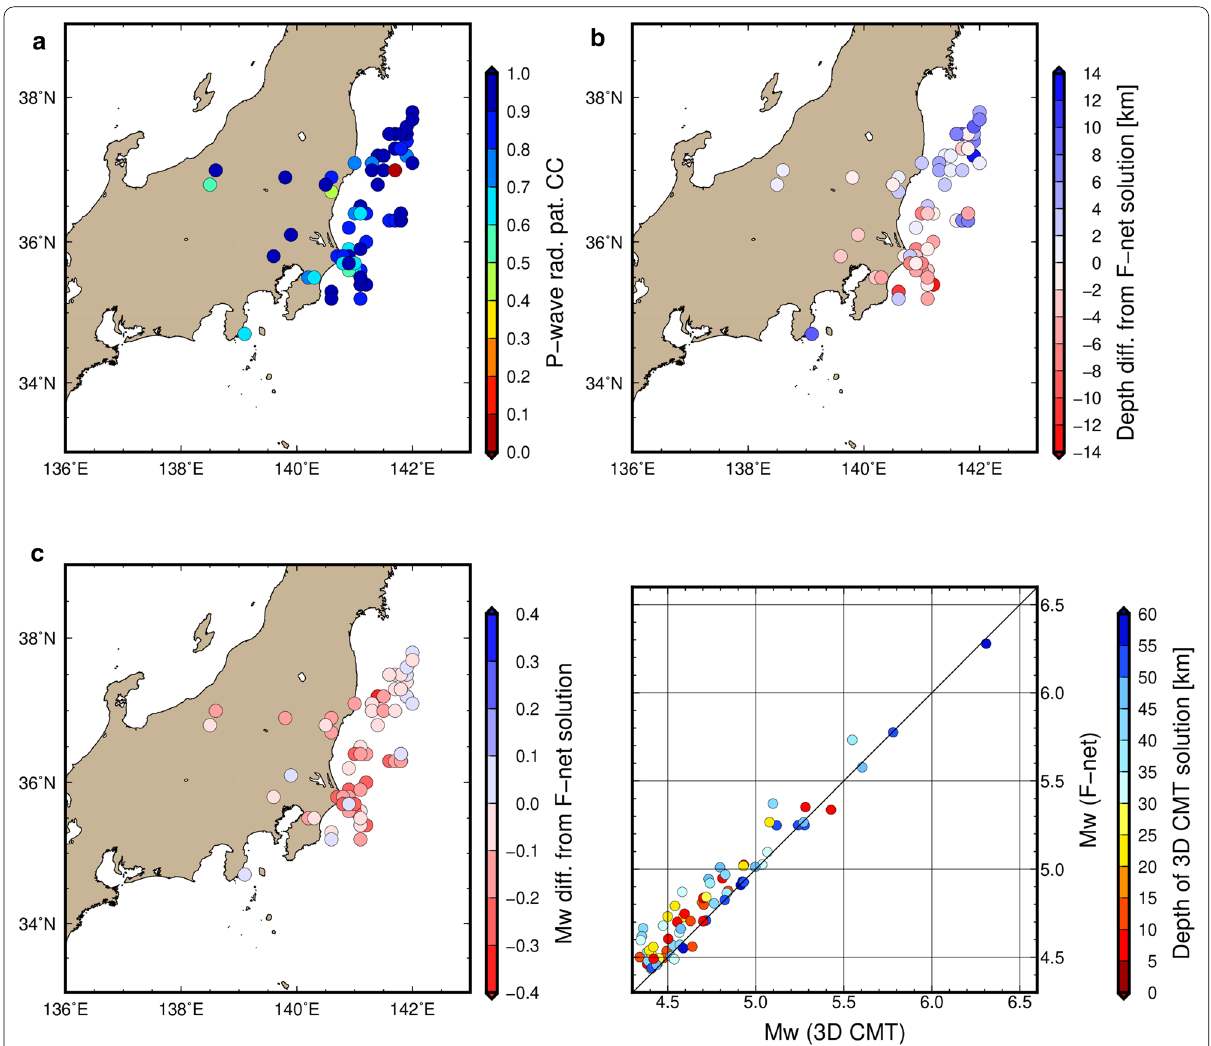
Fig. 4 Differences between 3D CMT and F-net MT catalogs in the Kanto region. a Cross-correlation of P-wave radiation patterns (e.g., Kuge and Kawakatsu 1993; Helffrich 1997) between 3D CMT and F-net MT catalogs. b Depth differences and c Mw differences from F-net MT